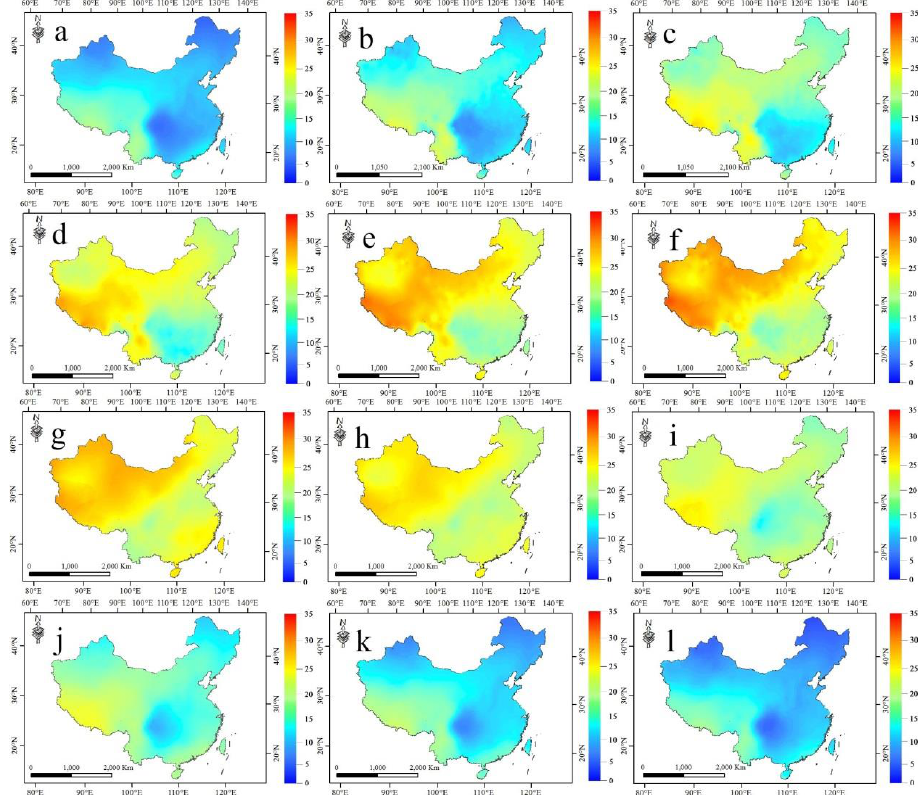
Figure 18. Distribution of the monthly mean SSR values throughout China during 1980–2015: ( a )